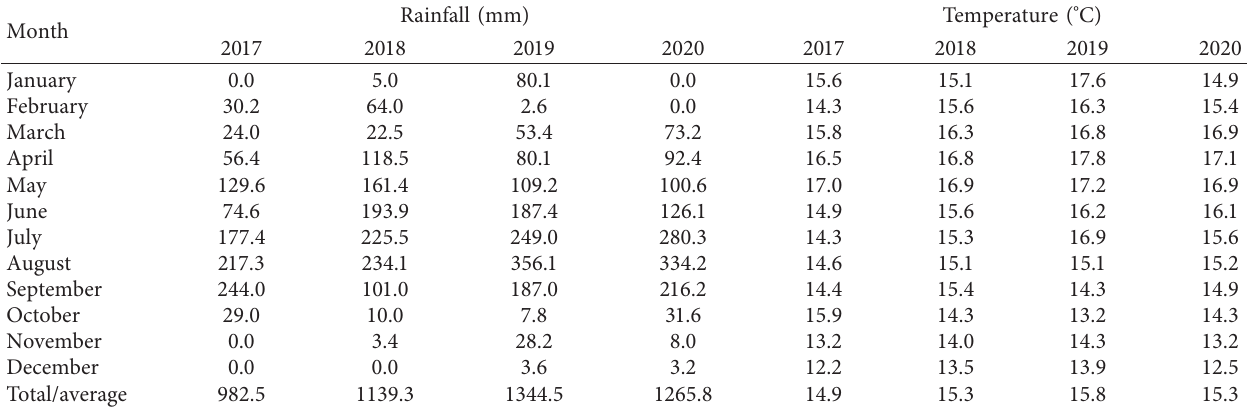
Table 2: Monthly rainfall and average temperature during the growing